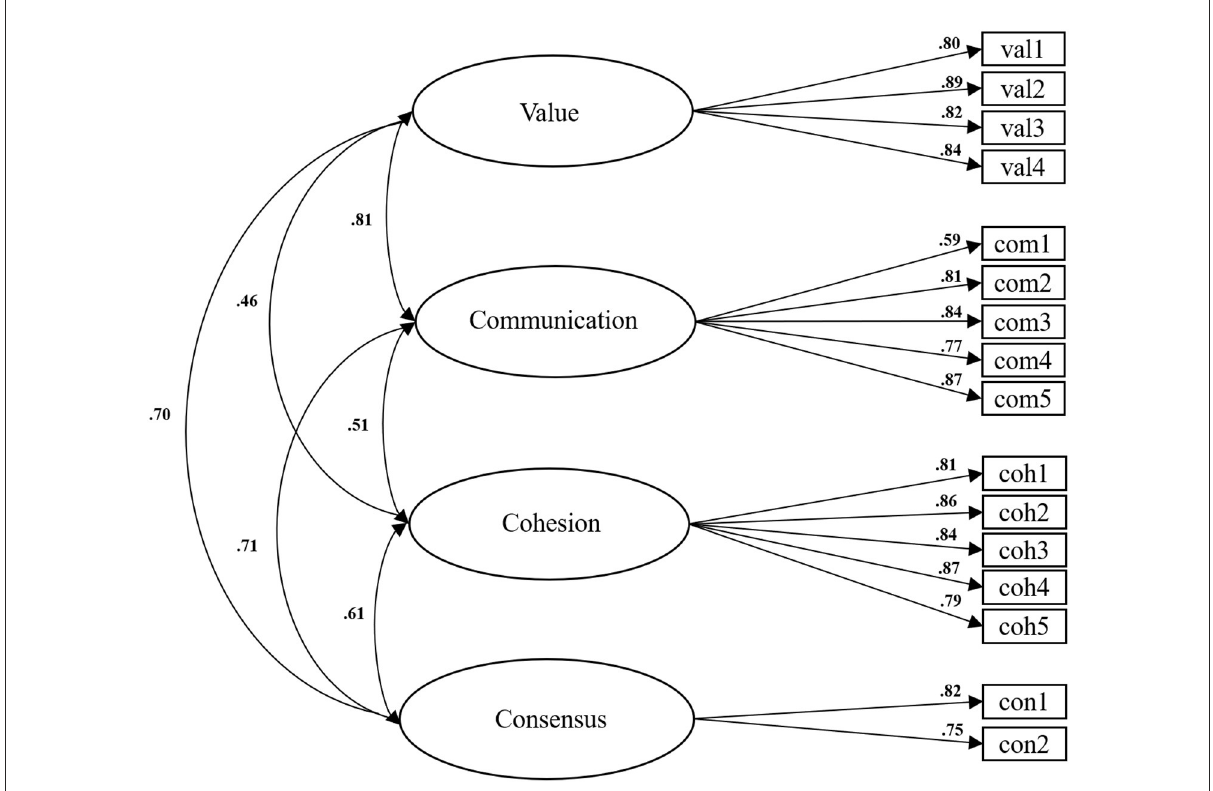
FIGURE2 FHC-NU (Sg) standardized factor loadings and inter-factor correlations.